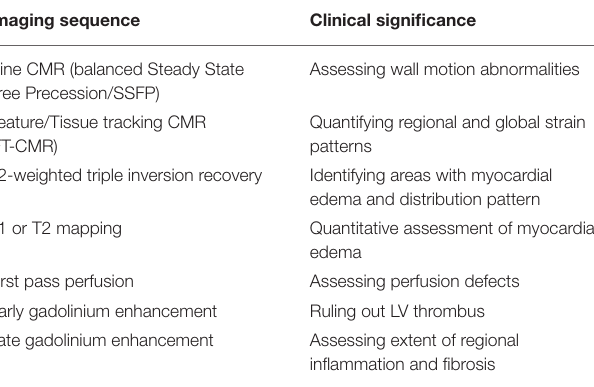
TABLE 2 | Important CMR parameters for the evaluation of stress